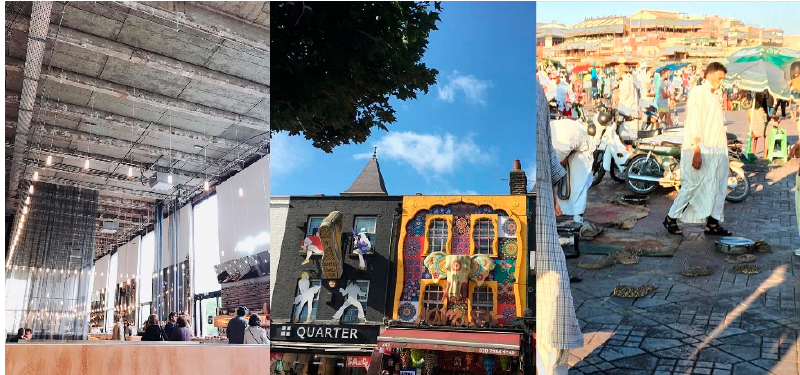
Figure 4. Three images from different instagram accounts, selected with a geo-based research, that show the reference places declared by